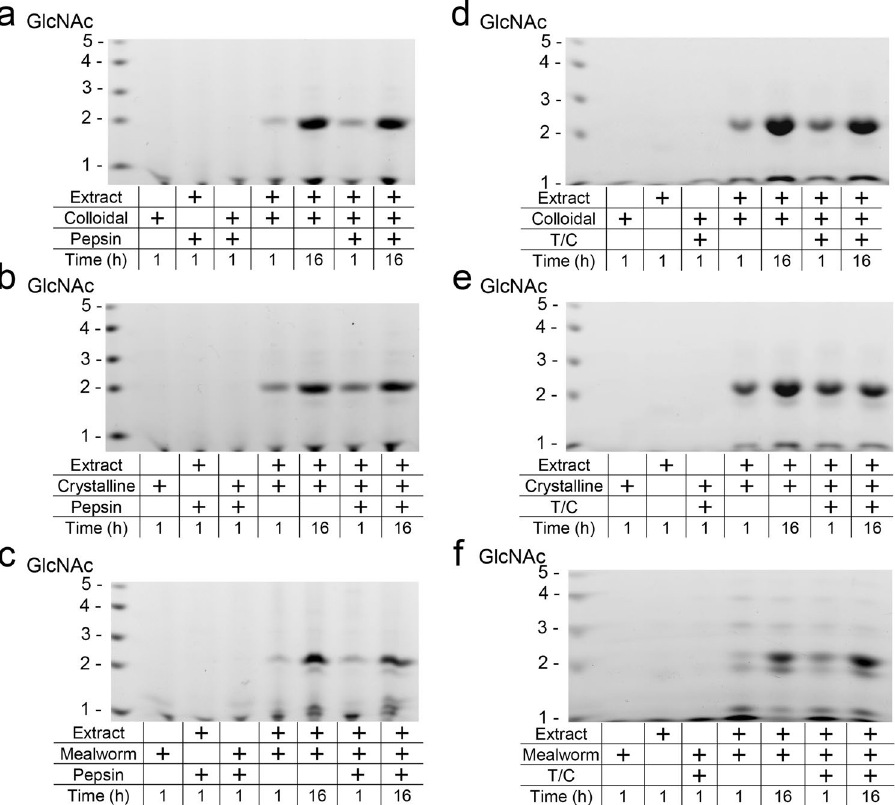
Figure 6. Chitin substrates and chitin-containing organisms are degraded by stomach extract. Degradation products were generated during incubation of ( a , d ) colloidal or ( b , e ) crystalline chitin and ( c , f ) mealworm sells with the extract proteins from stomach tissues. Incubation at pH 2.0 for 1 or 16 hours in the presence or being inhibited (adding pepstatin A) of pepsin ( a – c ) or at pH 7.6 for 1 or 16 hours in the presence of trypsin and chymotrypsin (pre-incubation at pH 2.0) ( d – f ). Degradation products were analyzed by the FACE method. Chitin oligomers are shown in the left margin as